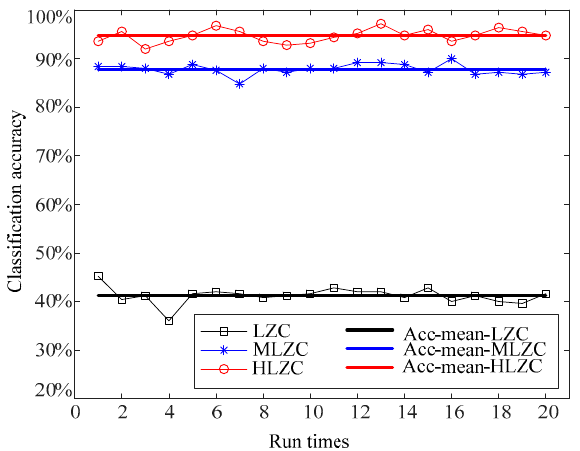
Figure 17. Diagnosis results of 20 trials using three methods in Experiment 2.